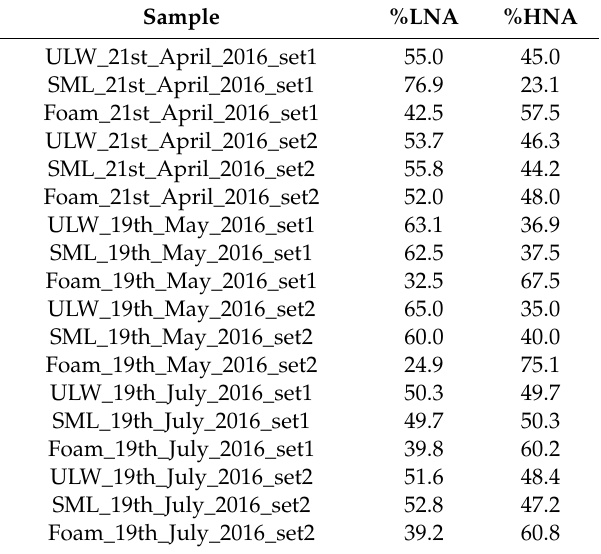
Table A1. Percentage (%) of high nucleic acid (HNA) and low nucleic acid (LNA) in di ff erent sample sets. ULW = underlying water (refers to 1-m depth), SML = sea-surface microlayer. Sample